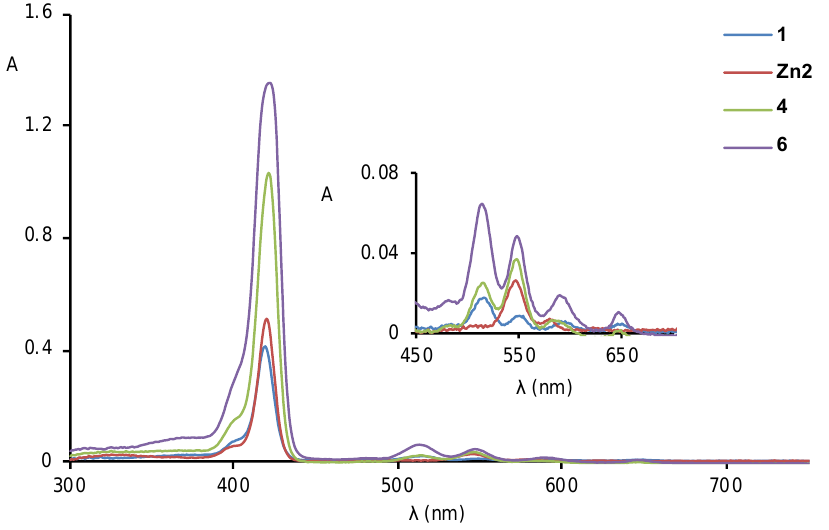
Figure 2. Absorption spectra of 1 , Zn 2 , 4 , and 6 in toluene. All compounds were used with a concentration of 1.0 μM. The inset shows an expansion of the Q bands.